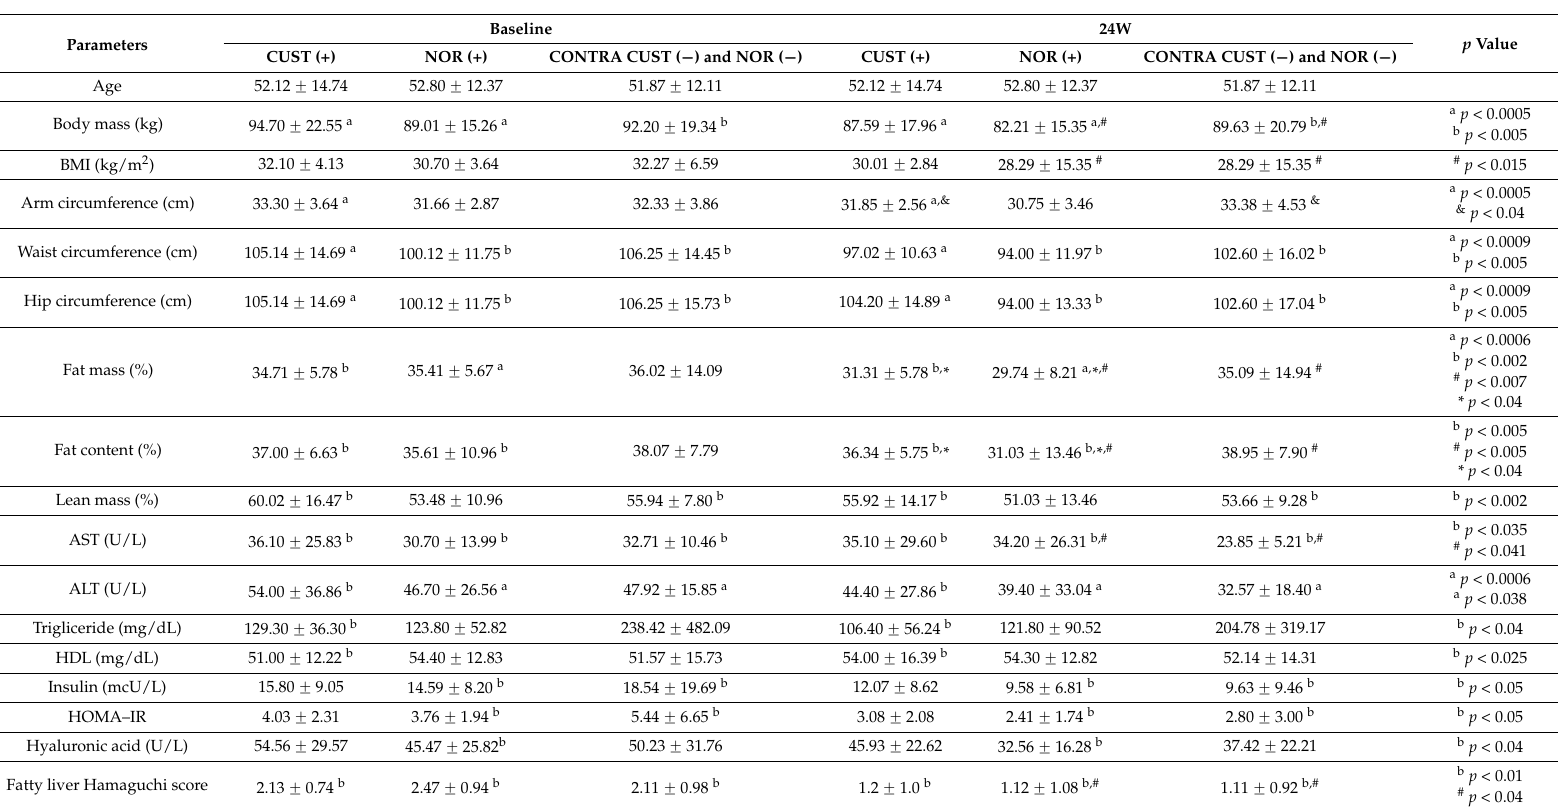
Table 1. Anthropological and biochemical characteristics of the study participants’ blood parameters at baseline and after six months of the diet in Model 1, with p -values of the comparison between subjects within this same intervention before and after six months. a p < 0.0005 Wilcoxon test, comparison between baseline and the fourth visit in this same group; b p < 0.005 Wilcoxon test, comparison between baseline and the fourth visit in this same group; * Mann-Whitney U test, comparison between NIOR (+) and Cust (+); # Mann-Whitney U test, comparison between NIOR (+) and contrary diets NIOR ( ´ )/Cust ( ´ ); & Mann-Whitney U test, comparison between Cust (+) and contrary diets Cust ( ´ ) and NIOR ( ´ ). BMI: Body mass index; MUFA: monounsaturated fatty acids; PUFA: polyunsaturated fatty acids, HA: hyaluronic